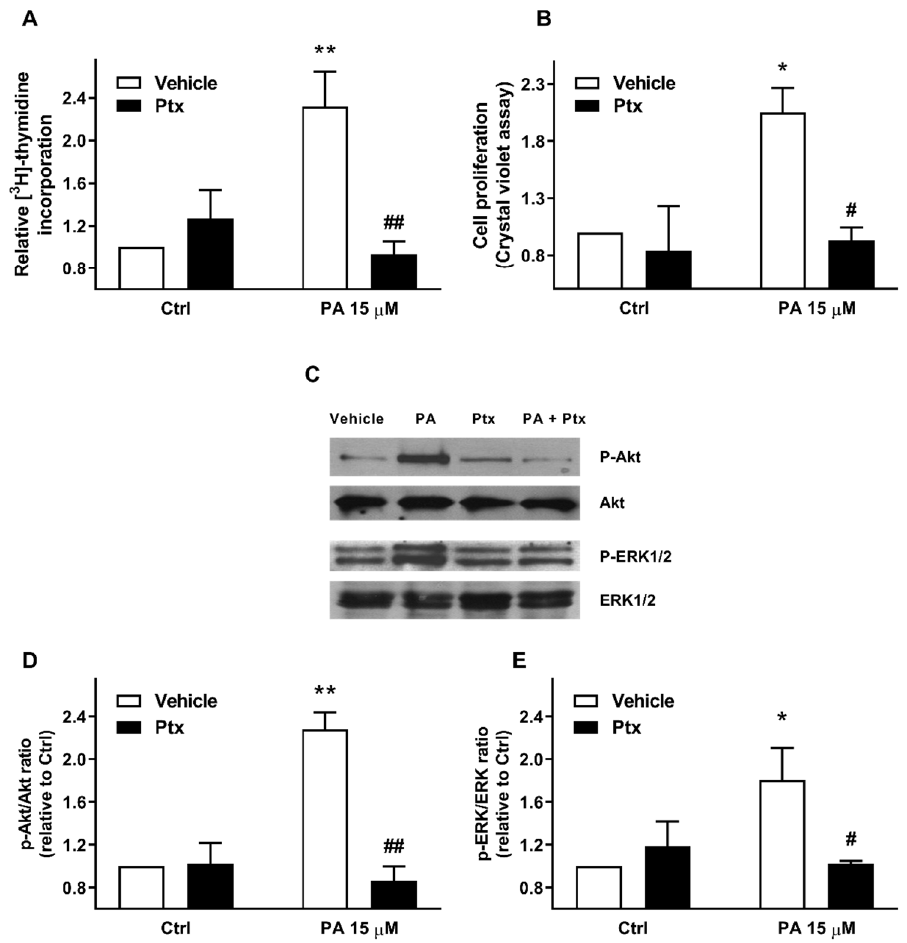
Figure 4. Pertussis toxin inhibits PA-stimulated myoblast proliferation and Akt and ERK1/2 phosphorylation. Myoblasts were serum-starved in DMEM supplemented with 0.1% BSA for 24 h. ( A ) Cells were preincubated for 16 h with 0.5 µ g/mL pertussis toxin (Ptx) and then further treated with 15 µ M PA or vehicle for 16 h, as indicated. [ 3 H]Thymidine incorporation was measured as described in the Materials and Methods section. Results are expressed relative to the control value without agonist and are the mean ± SEM of 3 independent experiments performed in triplicate. (** p < 0.01, control versus PA-treated cells, ## p < 0.01; PA-treated cells versus PA-treated cells in the presence of Ptx). ( B ) Cells were treated as in panel A. Cell proliferation was determined by staining the myoblasts with crystal violet as described in the Materials and Methods section. Results are expressed relative to the control value without agonist and are the mean ± SEM of 3 independent experiments performed in triplicate. (* p < 0.05, control versus PA-treated cells, # p < 0.05; PA-treated cells versus PA-treated cells in the presence of Ptx). ( C ) C2C12 cells were preincubated for 16 h with 0.5 µ g/mL Ptx. The myoblasts were then challenged with 15 µ M PA or vehicle for 5 min, as indicated. Cell lysates were analyzed by western blotting as described in the Materials and Methods section. Phosphorylation of Akt (Ser473) and ERK were determined using specific antibodies to phospho-Akt (P-Akt), or phospho-ERK1/2 (P-ERK1/2). Equal loading of protein was monitored using specific antibodies to total Akt and ERK1/2. Panel C shows a representative blot of three independent experiments. ( D , E ) Results of scanning densitometry of the exposed films. Data are expressed as arbitrary units of intensity relative to the control values in the absence of agonist or Ptx (Ctrl) and are the mean ± SEM of 3 replicate experiments. (* p < 0.05; ** p < 0.01; control versus PA-treated cells, # p < 0.05, ## p < 0.01; PA-treated cells versus PA-treated cells in the presence of Ptx, as